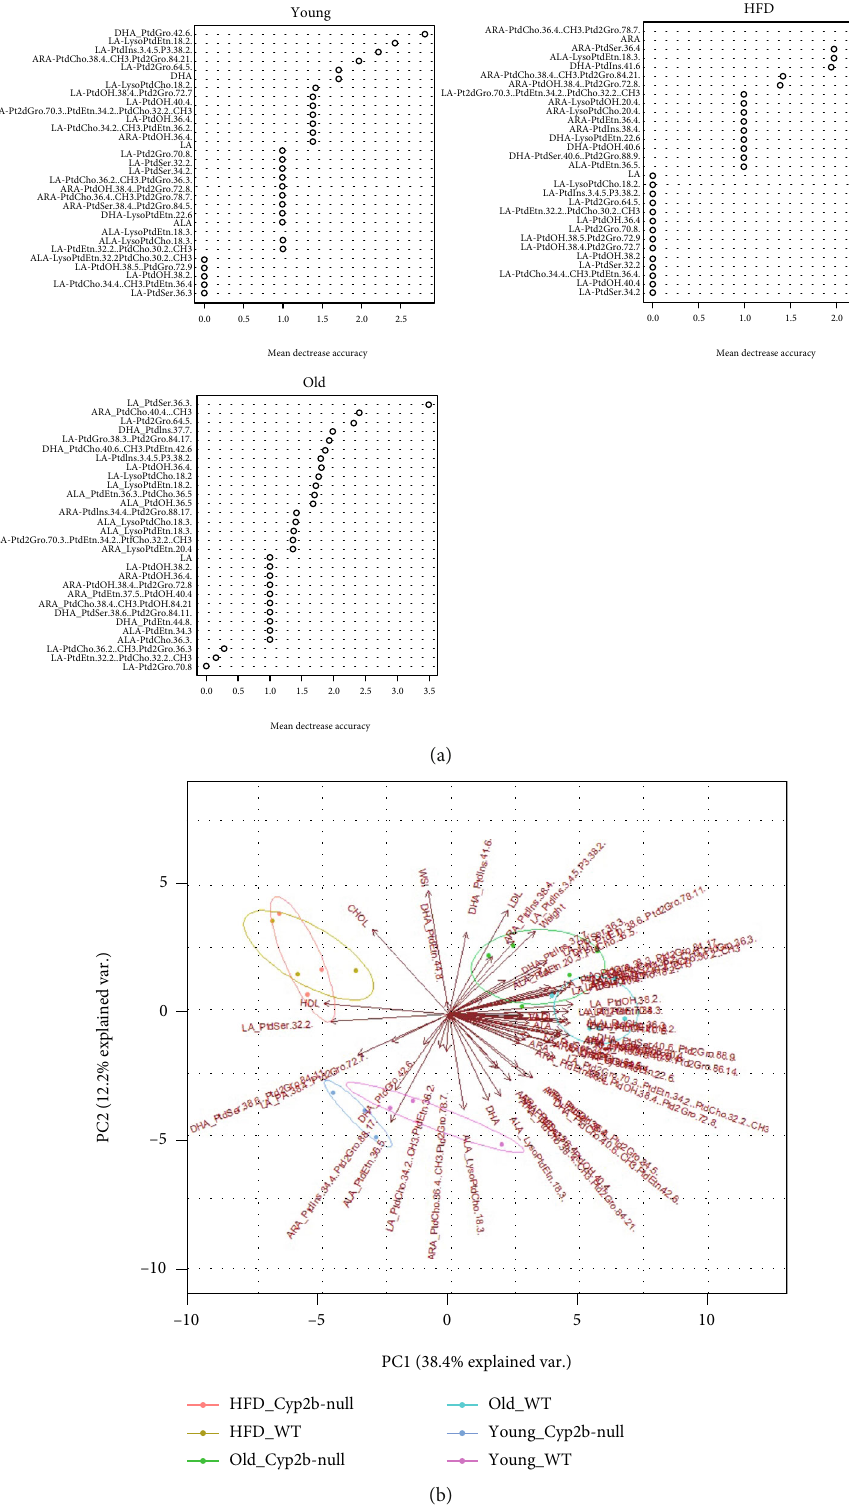
Figure 8: Lipid species and measured variables associated with di ff erences between Cyp2b-null and WT mice. (a) Random forest analysis of key lipids predictive of di ff erences between Cyp2b-null and WT mice. (b) Principal component analysis (PCA) biplot showing relationships between treatment groups and measured variables such as physiological parameters, serum lipids, and phospholipid species. Variables include serum lipids, WAT somatic index (WSI), body weight, and lipid species in order to associate speci fi c biochemical parameters with di ff erent treatment groups (diet and age) and genotypes (WT and